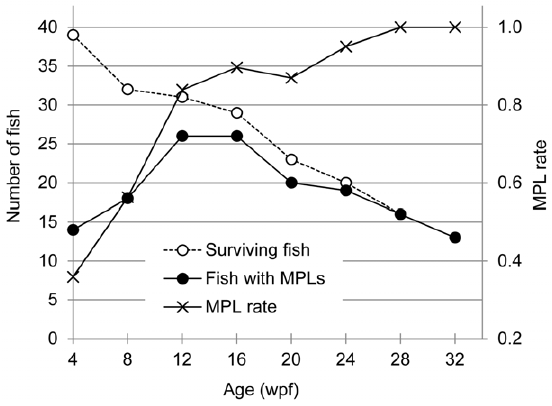
Figure 5. Age dependence of MPL incidence and survival in Tg ( tyr:HRAS G12V ) / Tg ( hsp:cre ) medaka. The transgenic fish were subjected to heat treatment at 1 wpf and then monitored for the development of MPLs and death. A single monitoring was performed with 39 Tg(tyr:HRAS G12V ) / Tg(hsp:cre) medaka at 4 wpf.